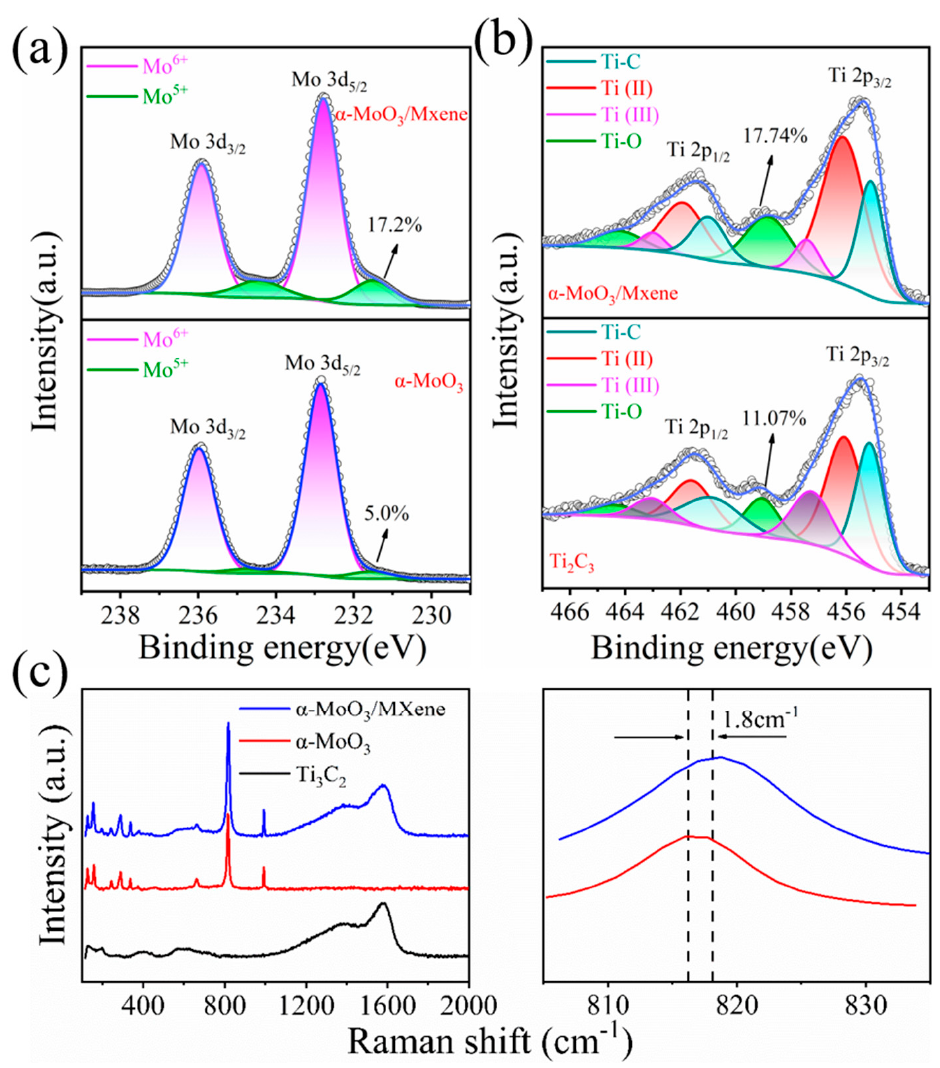
Figure 2. ( a ) Mo 3d XPS spectra of α− MoO 3 and α− MoO 3 /MXene. ( b ) Ti 2p XPS spectra of Ti 3 C 2 and α− MoO 3 /MXene. ( c ) Raman spectra of Ti 3 C 2 , α− MoO 3 , and α− MoO 3 /MXene.